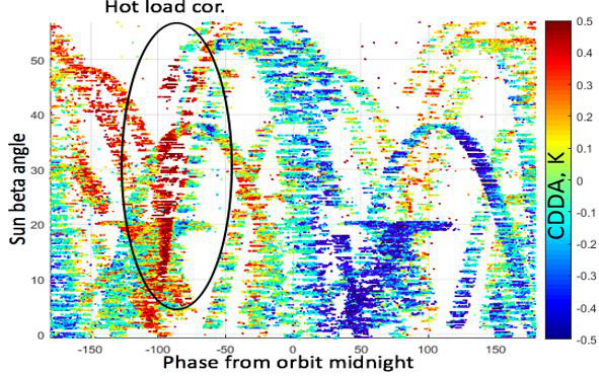
Figure 14. Change in DD anomaly (CDDA) from V7 to V8 based on the solar coordinates of channel 19.35 V.